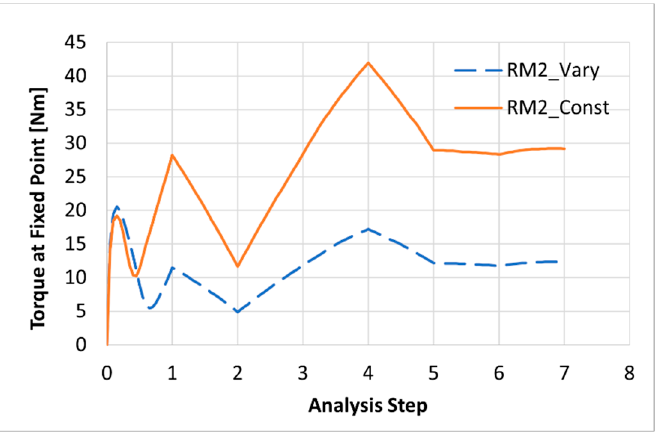
Figure 15. Variation of torque at fixed point with respect to analysis steps according to angle distri- bution.